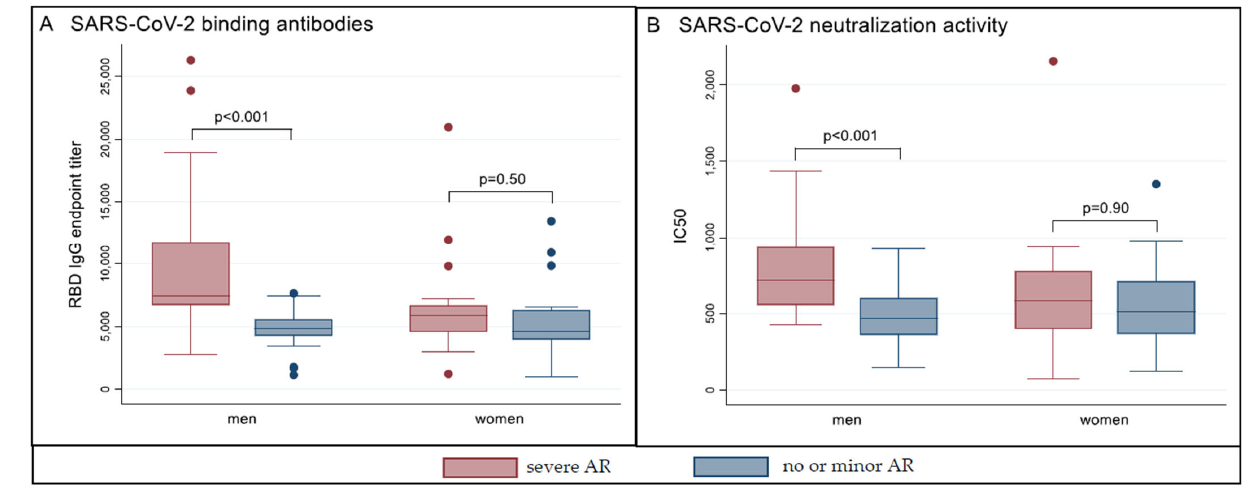
Figure 1. Antibody response and neutralization activity according to reactogenicity after second vaccination with BNT162b2. Shown are boxplots of RBD ‐ specific SARS ‐ CoV ‐ 2 ‐ IgG endpoint titers (Panel ( A )) and half maximal inhibitory concentrations (IC 50 ) in a pseudovirus neutralization assay (Panel ( B ), one outlier not included, leftmost bar IC 50 4231), separately in men and women. Dots indicate outliers. AR = adverse reaction(s). Severe AR = any adverse reaction(s) after first and/or second vaccination resulting in sick leave; no or minor AR = no or only minor injection side symptoms after first and second